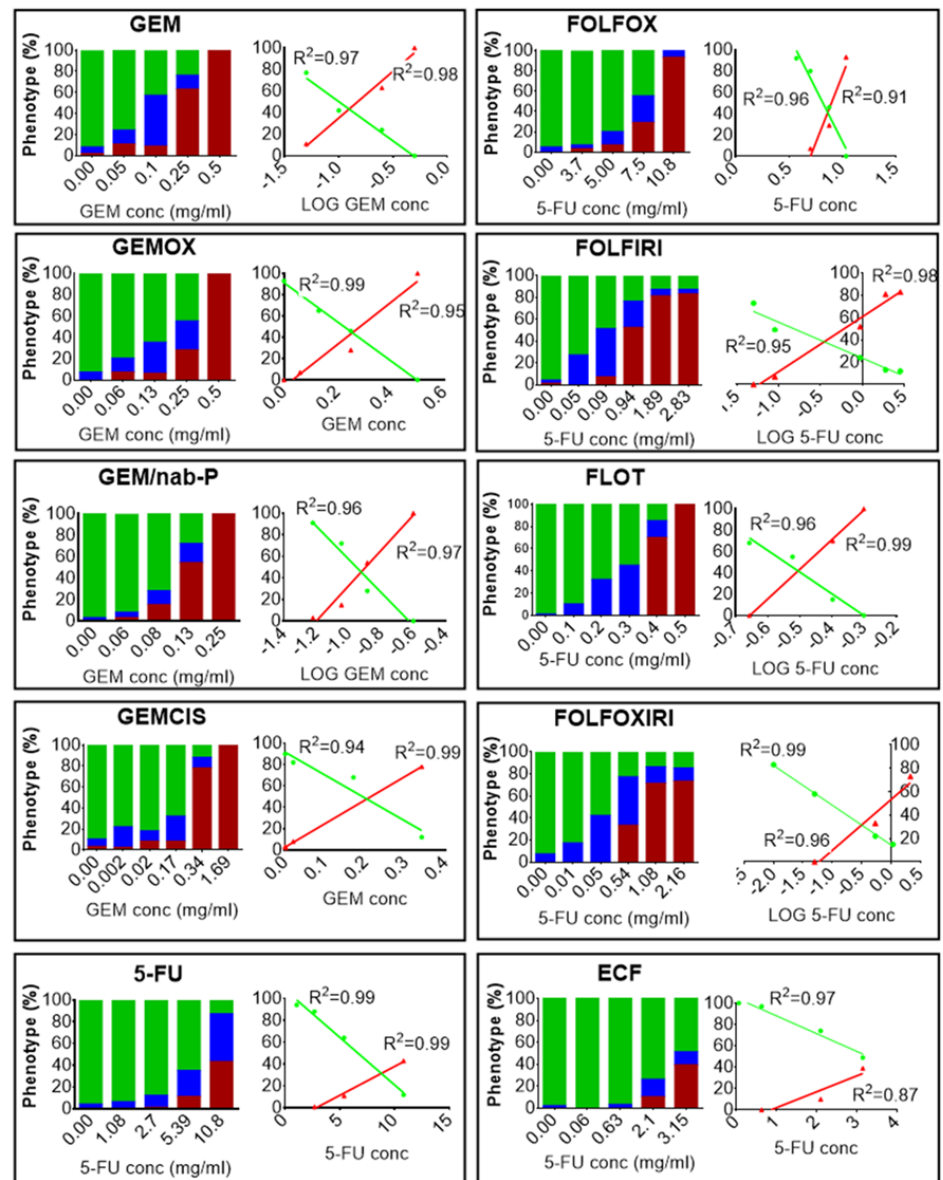
Figure 1. Chemotherapy safety study. Zebrafish 2 days post fertilization (dpf) embryos were incubated with media (E3 supplemented with 100 U / mL penicillin and 100 µ g / mL streptomycin) modified with chemotherapy drugs or not modified at 35 ◦ C for 3 days. At the end of the treatment, the percentages of dead embryos (red), aberrant (blue) and normal phenotype (green) were evaluated after fixation and stereomicroscope observation. In GEM, GEMOX, GEM / nab-P, GEMCIS, we report the Gemcitabine concentrationinthex-axis(theconcentrationsoftheotherdrugsareomittedbutareprovidedinTableS1). In 5-FU, FOLFOX, FOLFIRI, FLOT, FOLFOXIRI, ECF, we report the 5-Fluorouracil concentration in the x -axis (the concentrations of the other drugs are omitted but are provided in Table S1). The control group showed a 10% alteration from the normal phenotype. For each chemotherapy regimen, a dose-response and the relative linear regression analysis of the normal phenotype (green line) and the dead embryos (red line) are shown. The resulting R square is reported. The results presented are a pool from three independent biological replicates ( n =